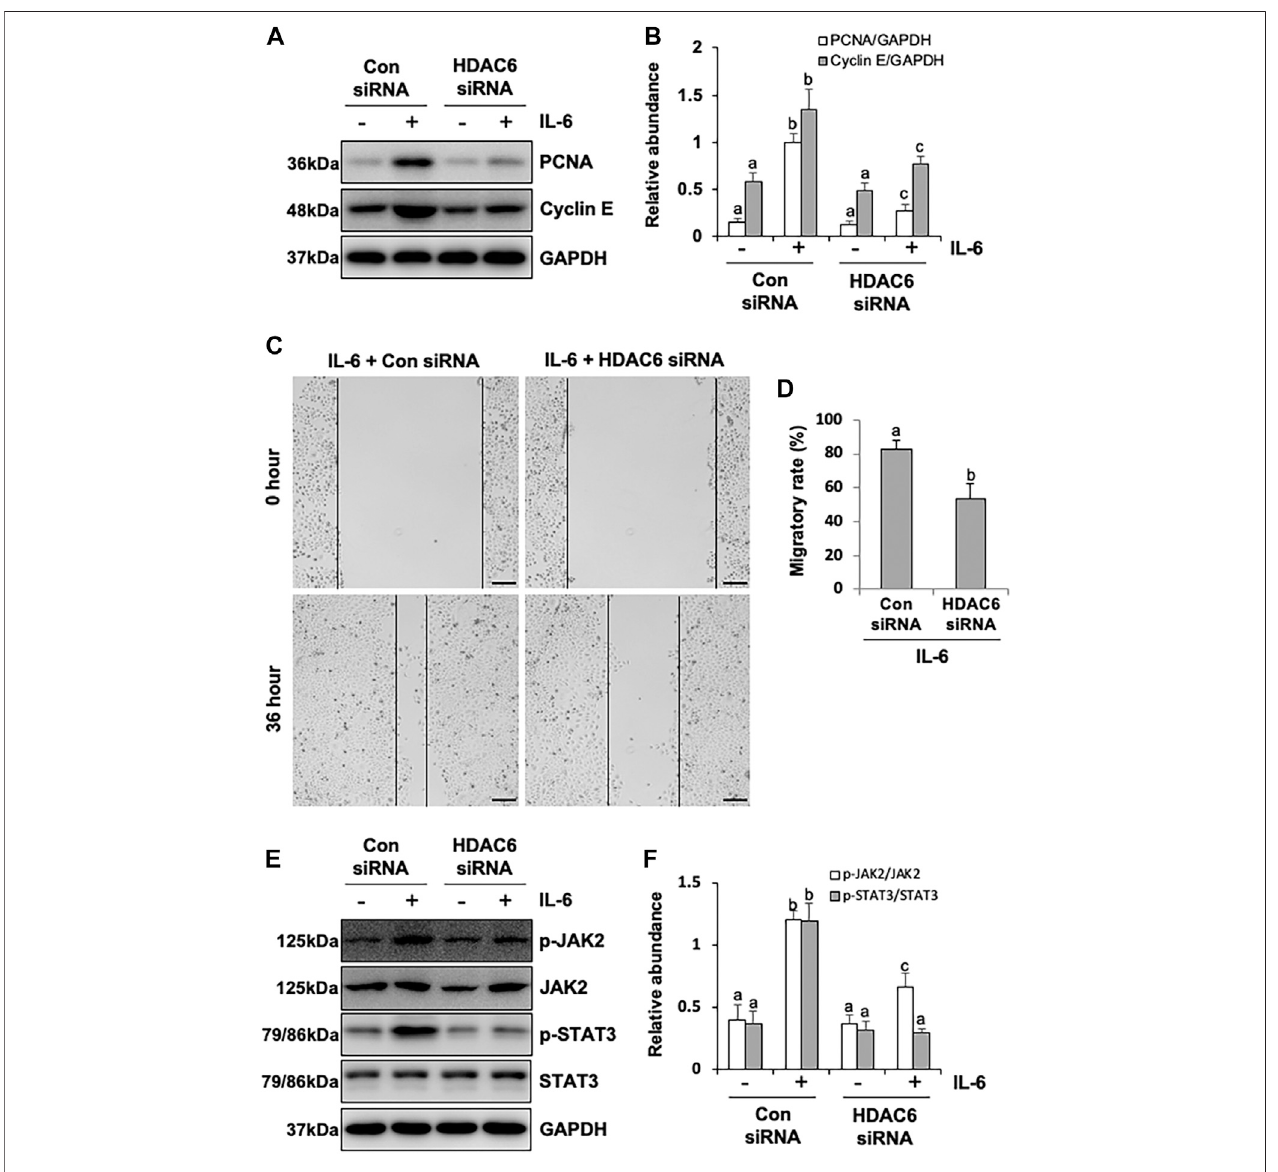
FIGURE 7 | siRNA-medicated silencing of HDAC6 inhibits proliferation and migration through the JAK2/STAT3 signaling pathway in human peritoneal mesothelial cells. (A) Celllysatesweresubjectedtotheimmunoblotanalysiswithspeci fi cantibodies against PCNA, CyclinE,and GAPDH. (B) Expressionlevels ofPCNA and Cyclin E were quanti fi ed by densitometry and normalized with GAPDH. (C) The wound-healing assay of the HPMCs treated with IL-6 (100 ng/ml) in the presence of HDAC6 siRNA or scrambled siRNA. Photomicrographs of migrating cells were taken at 0 and 36 h. (D) The width ofthe wound wasmeasured, and the migratoryrate was calculated. (E) Cell lysates were subjected to the immunoblot analysis with speci fi c antibodies against p-JAK2, JAK2, p-STAT3, STAT3, and GAPDH. (F) Expression levels of p-JAK2 and p-STAT3 were quanti fi ed by densitometry and normalized with JAK2 and STAT3, respectively. Data are represented as the mean ± SEM (n (cid:1) 3). Means with different superscript letters are signi fi cantly different from one another ( p < 0.05). All scale bars (cid:1) 500 μ m.